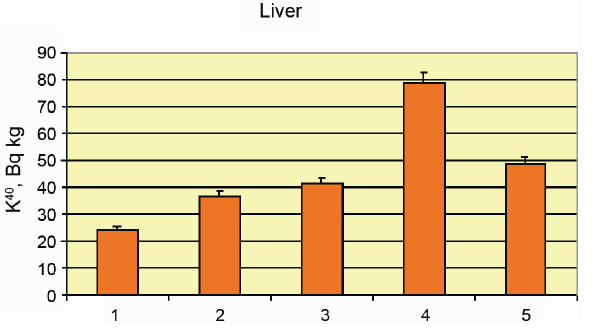
40 K in fox liver: